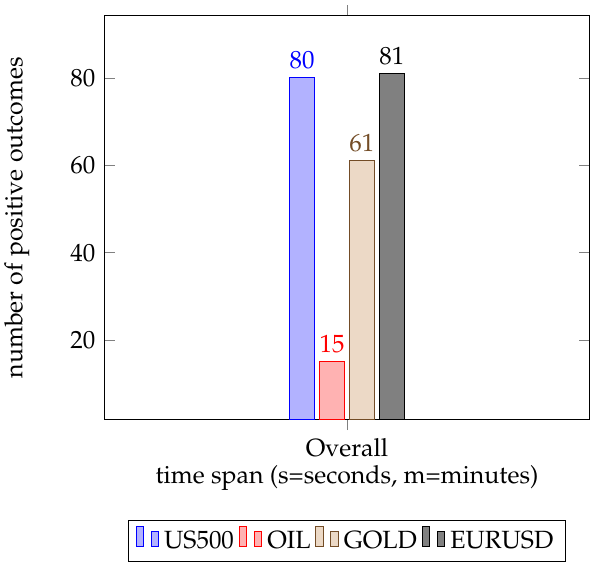
Figure 7. The total number of positive outcomes per asset, added across all time spans. We find a hardship in trading on the OIL market, but a successful application in the EURUSD and US500 foreign